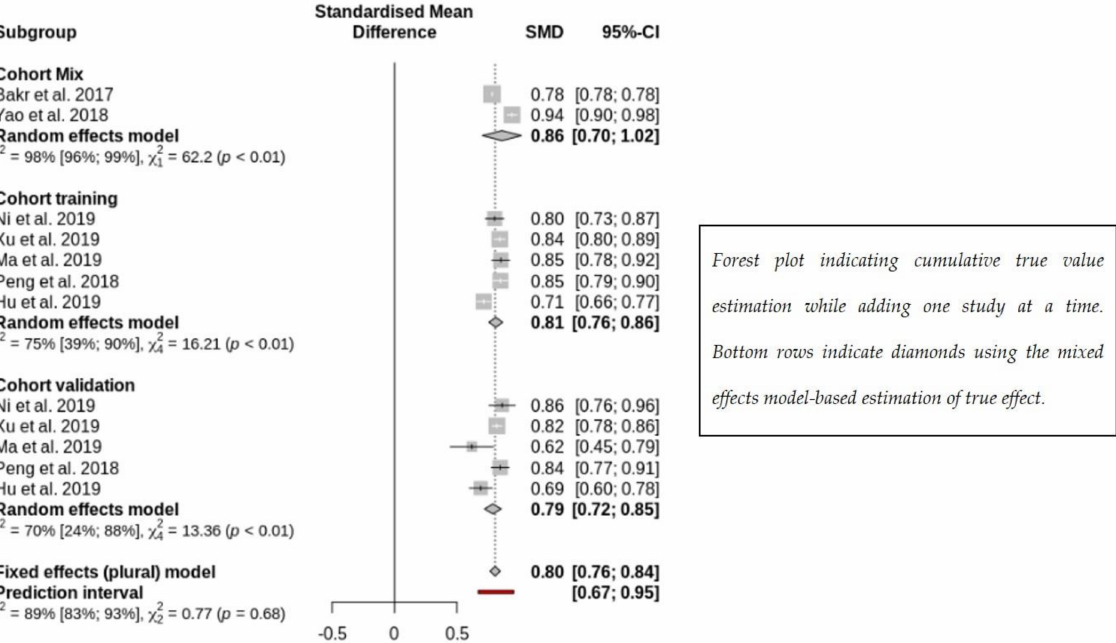
Figure 5. Radiomics prediction of microvascular invasion using mixed-effects modeling